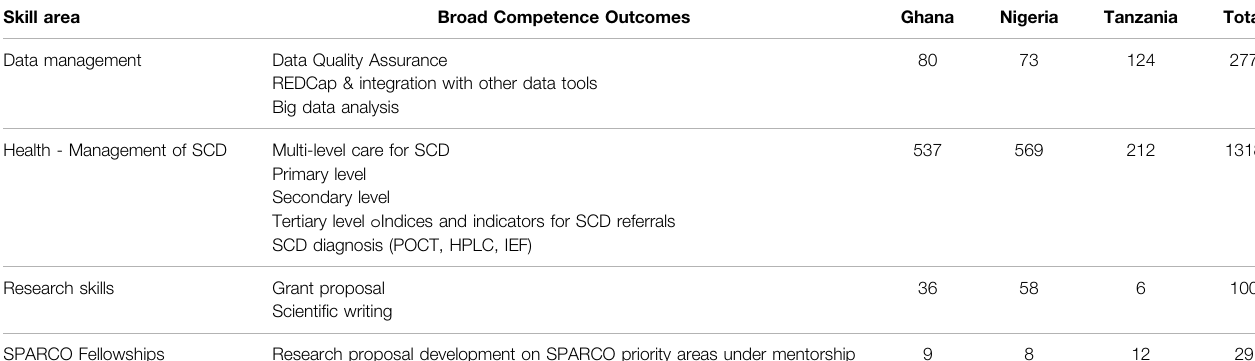
TABLE 3 | Numbers of participants in priority training areas by SPARCO sites. Skill